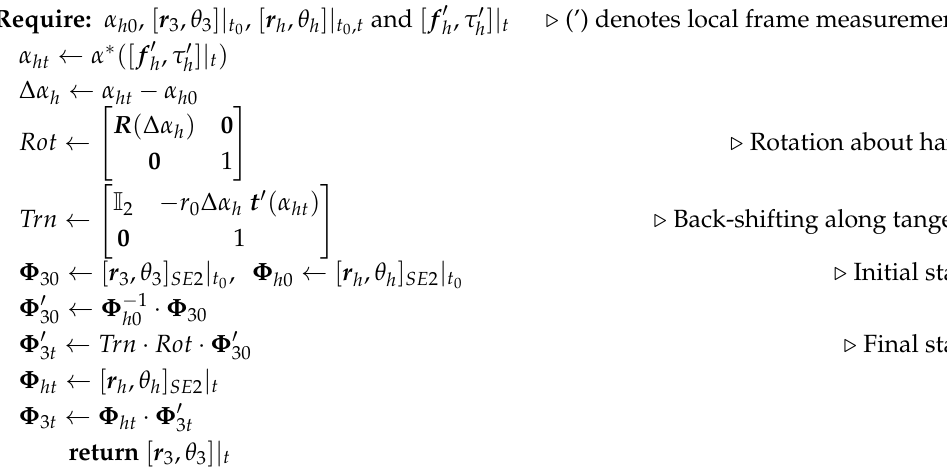
Algorithm 1 Computing final configuration from (i) knowledge of initial configuration and (ii) wrench in final configuration using information from hand h